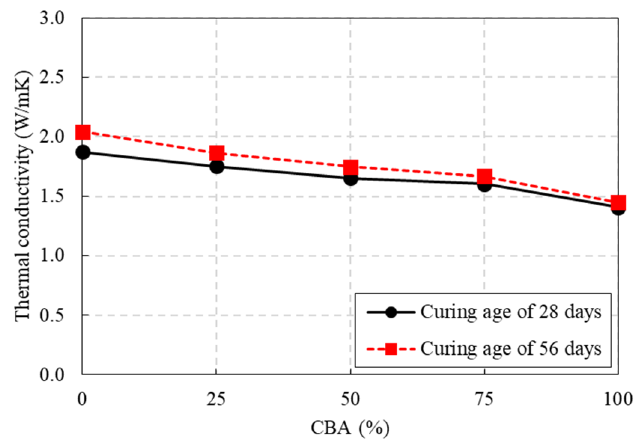
Figure 7. Thermal conductivity test results.